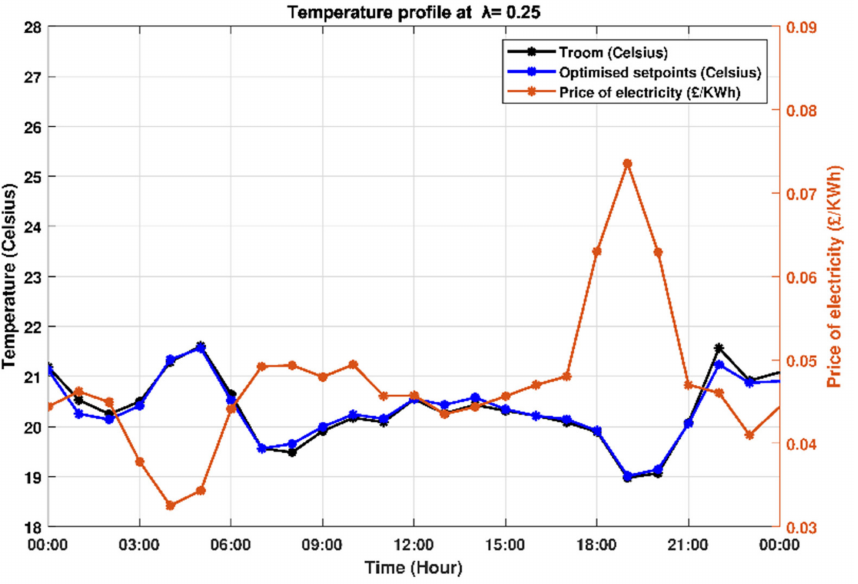
Figure 5. Room temperature and MPC-generated setpoints over 24 h when λ is set to 0.25—indicating higher preference for energy saving with some consideration for thermal